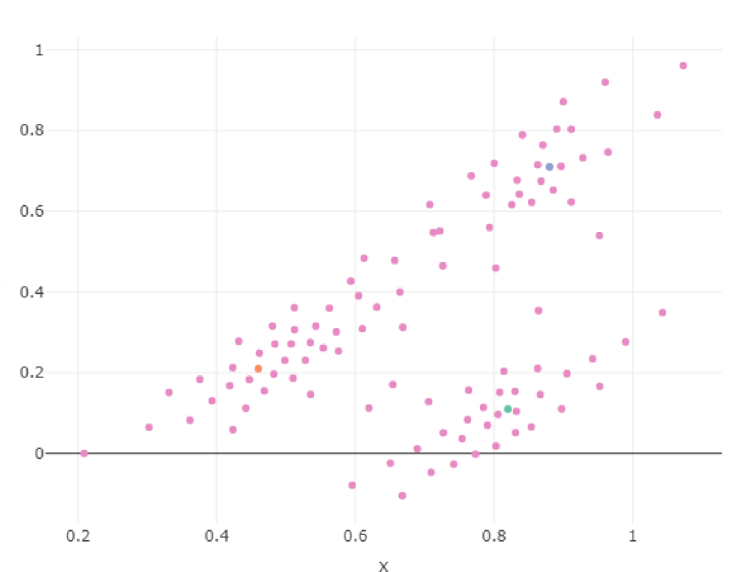
Figure 15. Two-dimensional plot of the weights in the second stratum SOM.